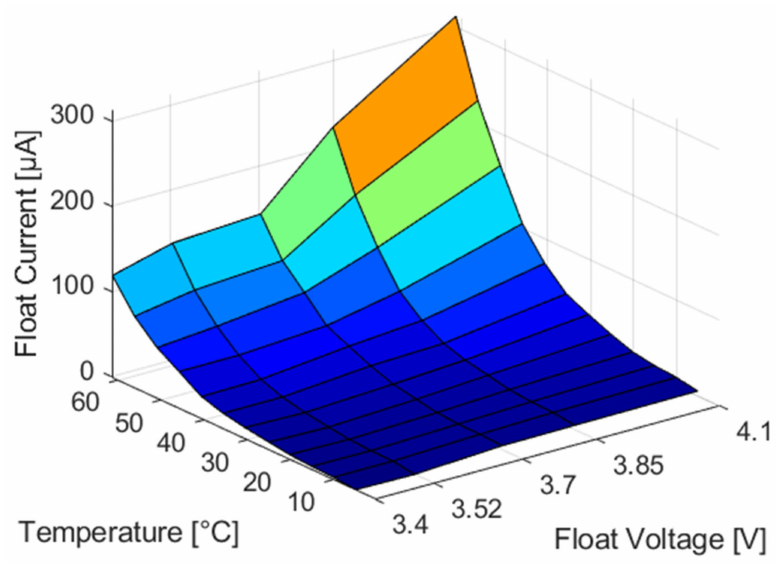
Figure 12. 3D plot of the previous figure float current vs. temperature and float